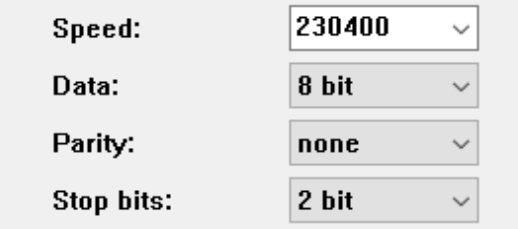
Figure 19. The achieved data rate of the proposed system.